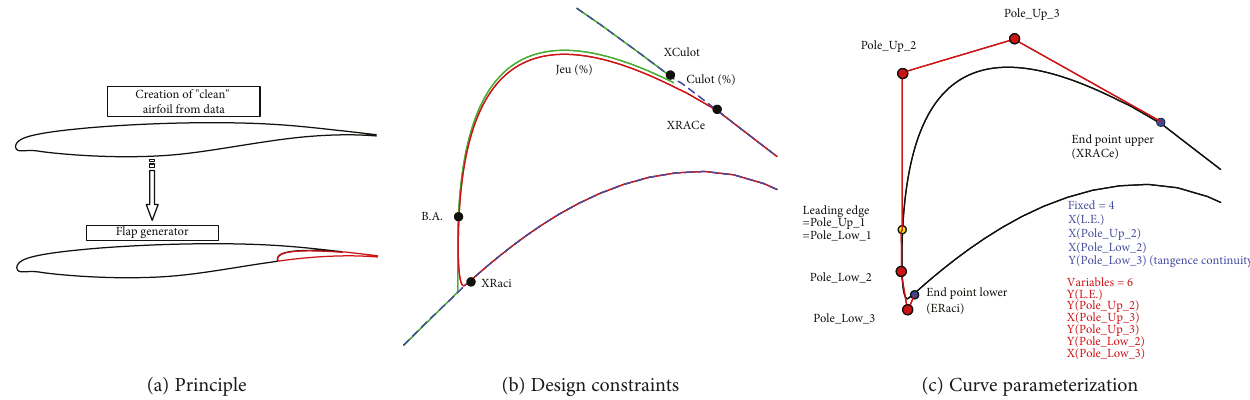
Figure 2: Flap shape generator used at